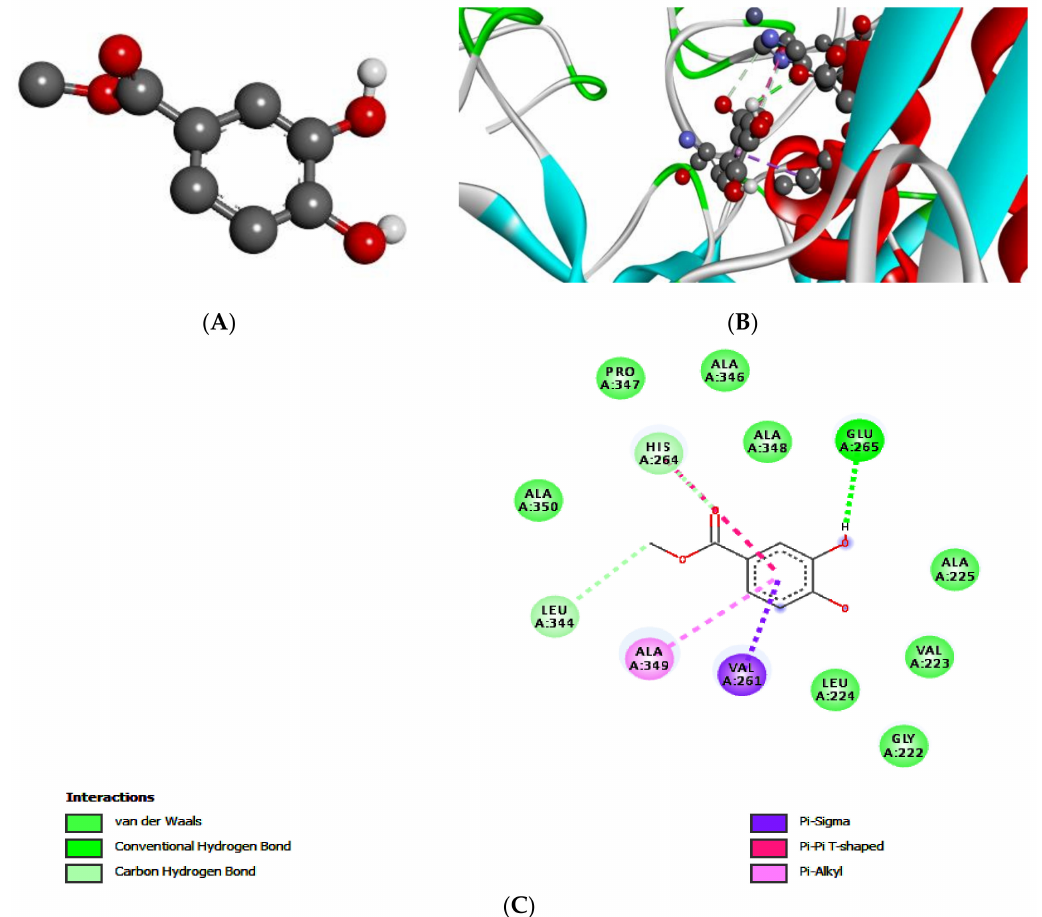
Figure 3. Interactions of legend (compound 1 ) with Leishmania tropica promastigote surface gp63 enzyme, drawn through Discovery Studio Visualizer client 2016. ( A ) PDB structure and best pose of methyl 3,4-dihyroxybenzoate; ( B ) General interaction of methyl 3,4-dihyroxybenzoate with its targets; ( C ) Specific interaction of compound 1 with its